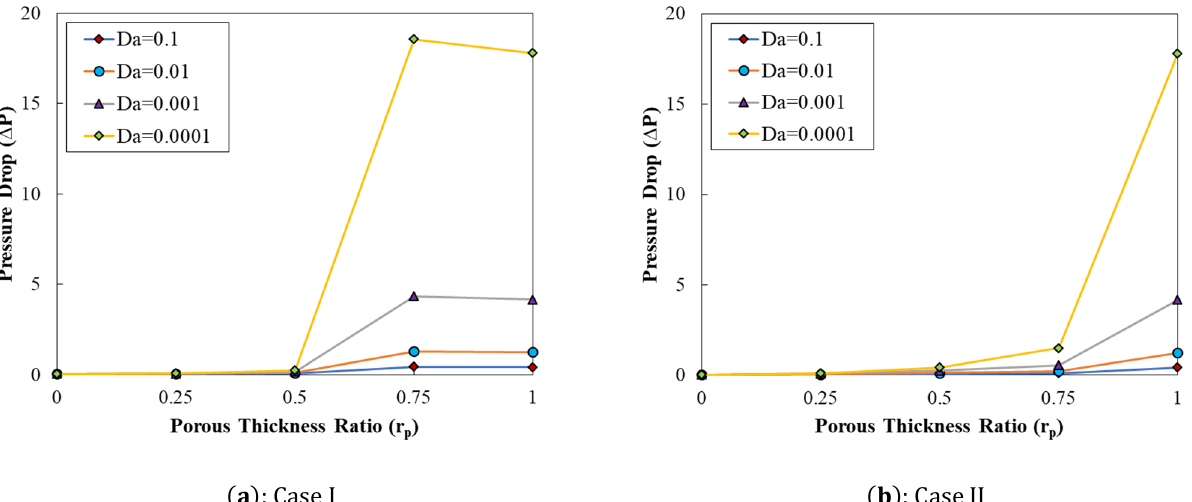
Figure 6. Pressure drop versus porous thickness ratio at diverse Darcy numbers for cases I and II, considering (𝜑 = 5%) .